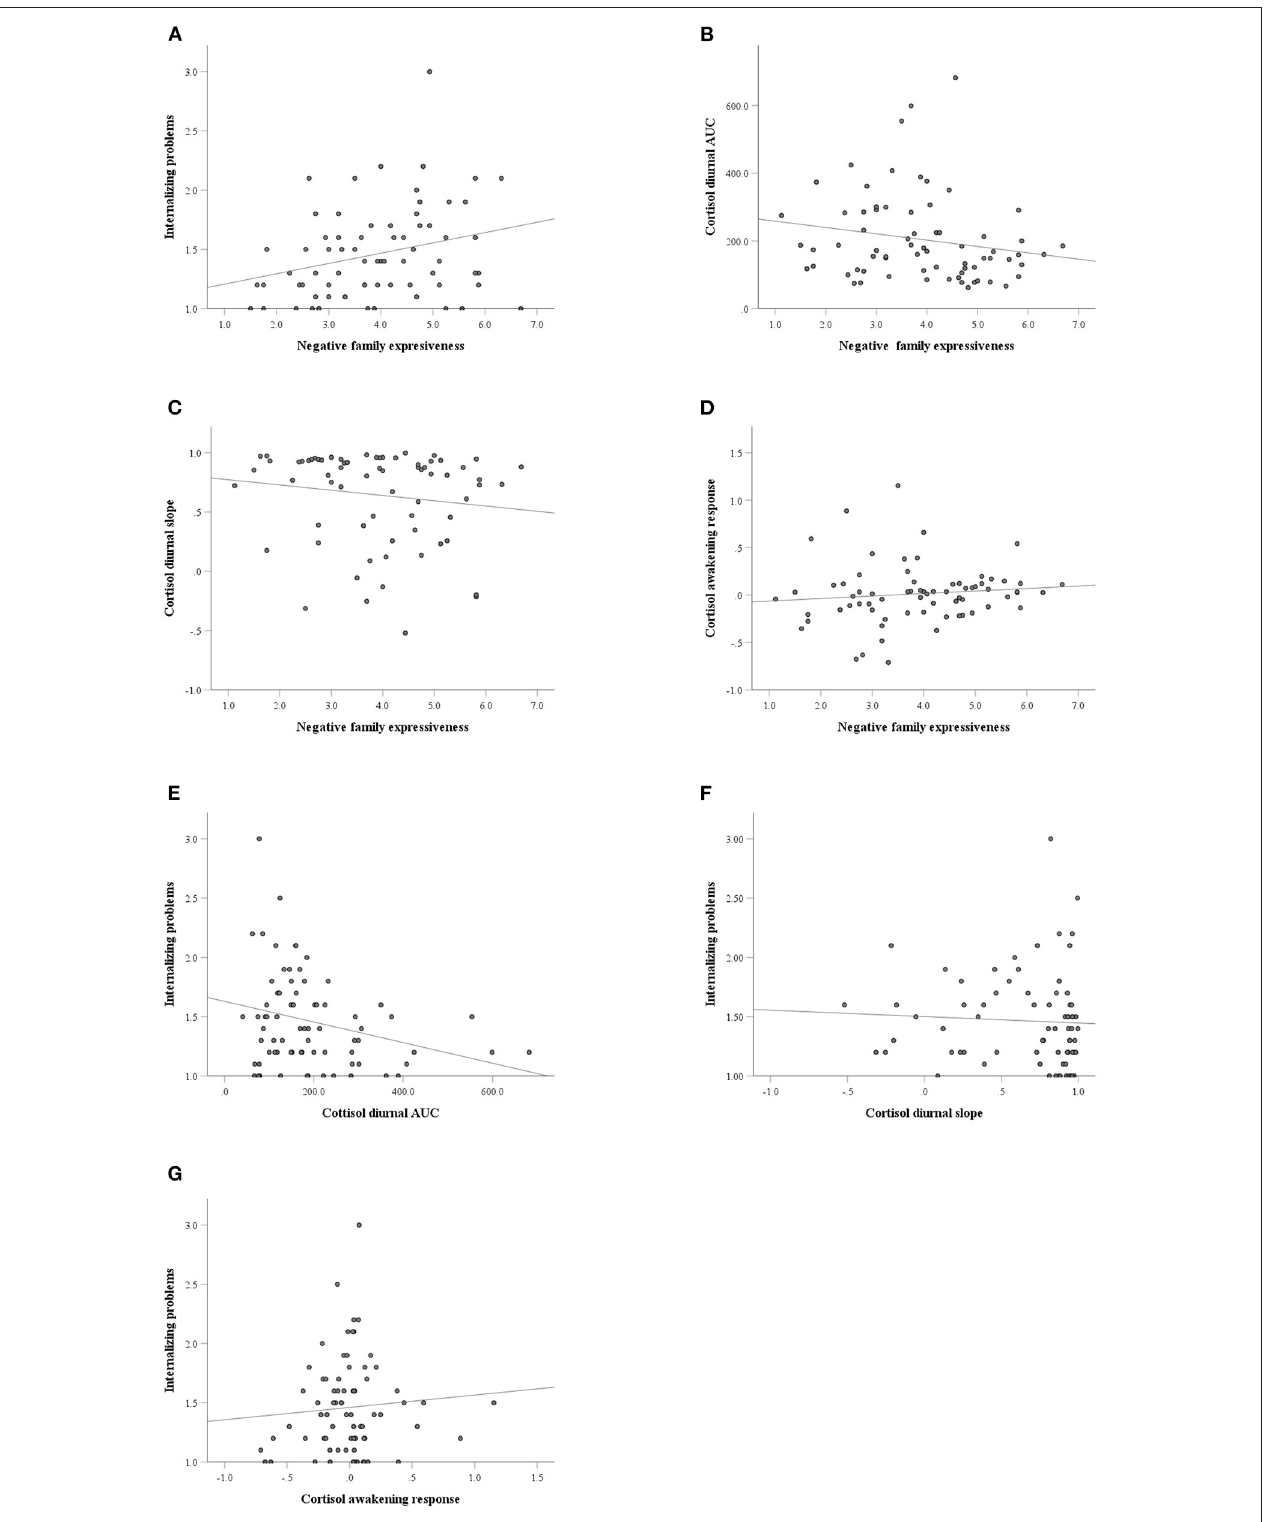
FIGURE 2 | The scatterplots of the correlations between the pairs of variables. (A) Negative family expressiveness and internalizing problems; (B) Negative family expressiveness and cortisol diurnal AUC (area under the curve); (C) Negative family expressiveness and cortisol diurnal slope; (D) Negative family expressiveness and cortisol awakening response; (E) Cortisol diurnal AUC and internalizing problems; (F) Cortisol diurnal slope and internalizing problems; (G) Cortisol awakening response and internalizing problems.